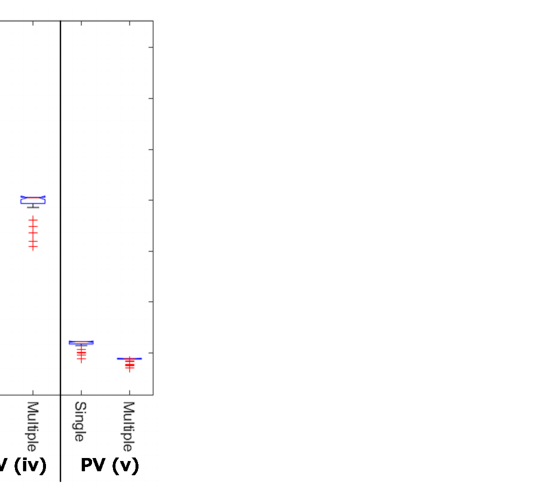
Figure 12. Box plot of prediction interval width; Single PV vs. Multiple PV forecast model at five locations.